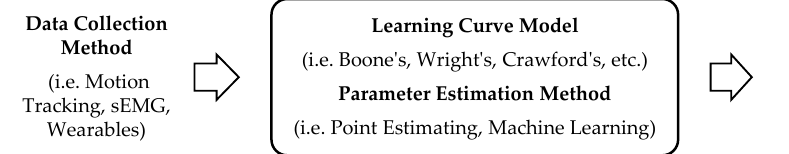
Figure 13. Conceptual Research Framework.